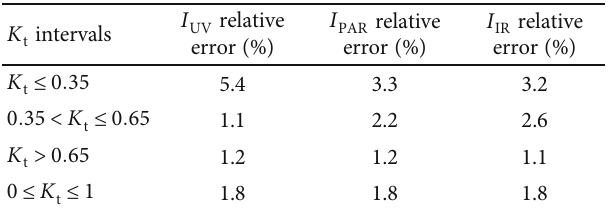
Figure 8: Graphical representation of the estimated values according to the measured values for di ff use radiation of Rabat (a), Tangier (b), Fez (c) and Marrakech (d). Table 12: RMBE calculated from estimated and measured values of I I I PAR , UV , and IR